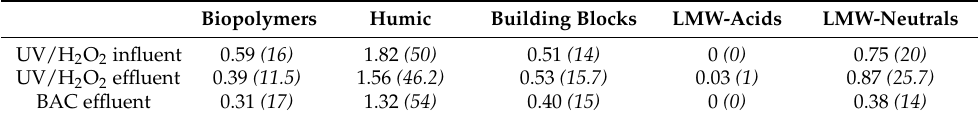
Table 4. DOC value of each